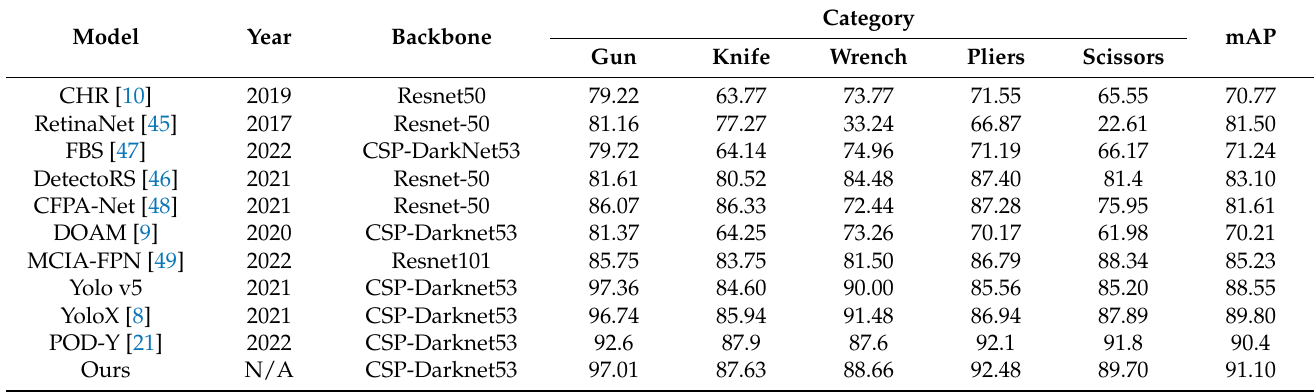
Table 2. Performance comparison results using different object detection methods on the SIXray